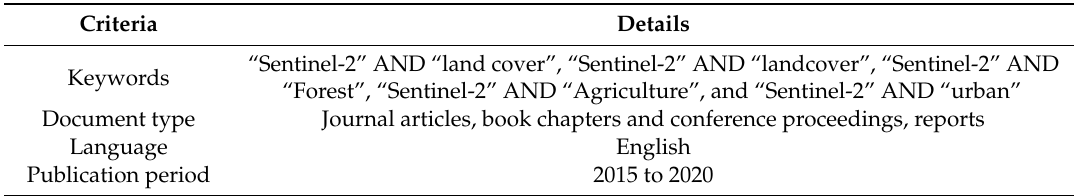
Table 1. The criteria used for the systematic literature